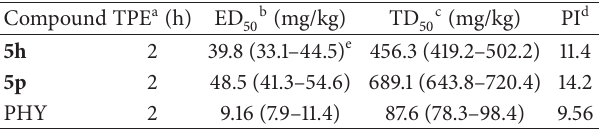
Table 5: Phase IV quantitative anticonvulsant evaluation of selected active compounds after oral